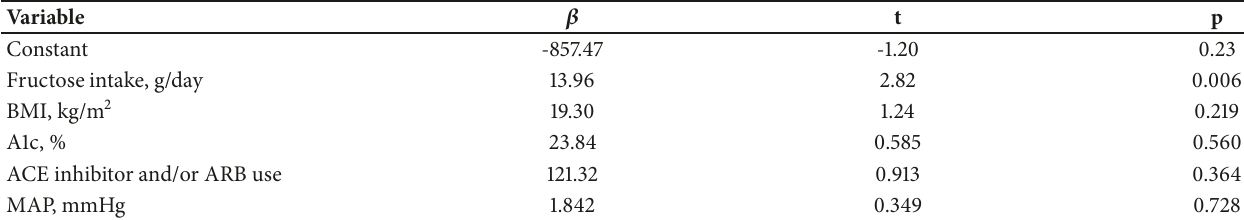
Table 5: Multiple linear regression analysis of variables associated with albuminuria in the subjects included in the study with albuminuria between 30 and 3500 mg/day (n = 86).